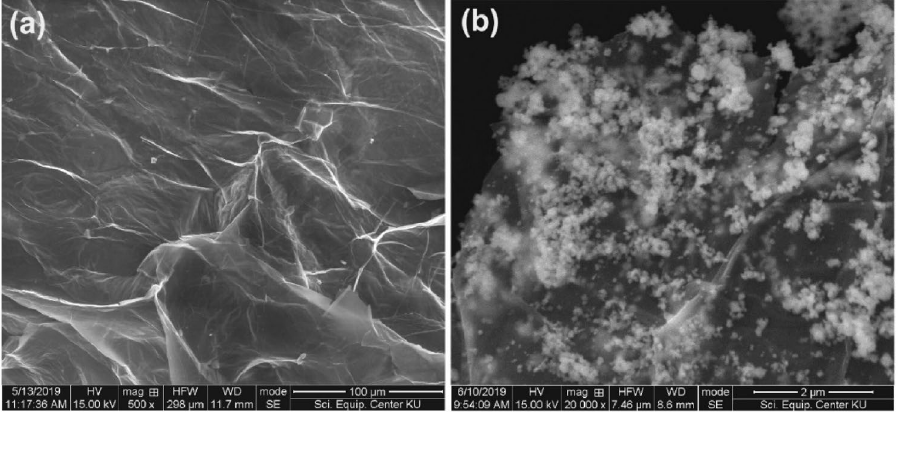
Fig. 3 Energy dispersive X-ray (EDX) spectrum of GO with the atomic percentage of C and O